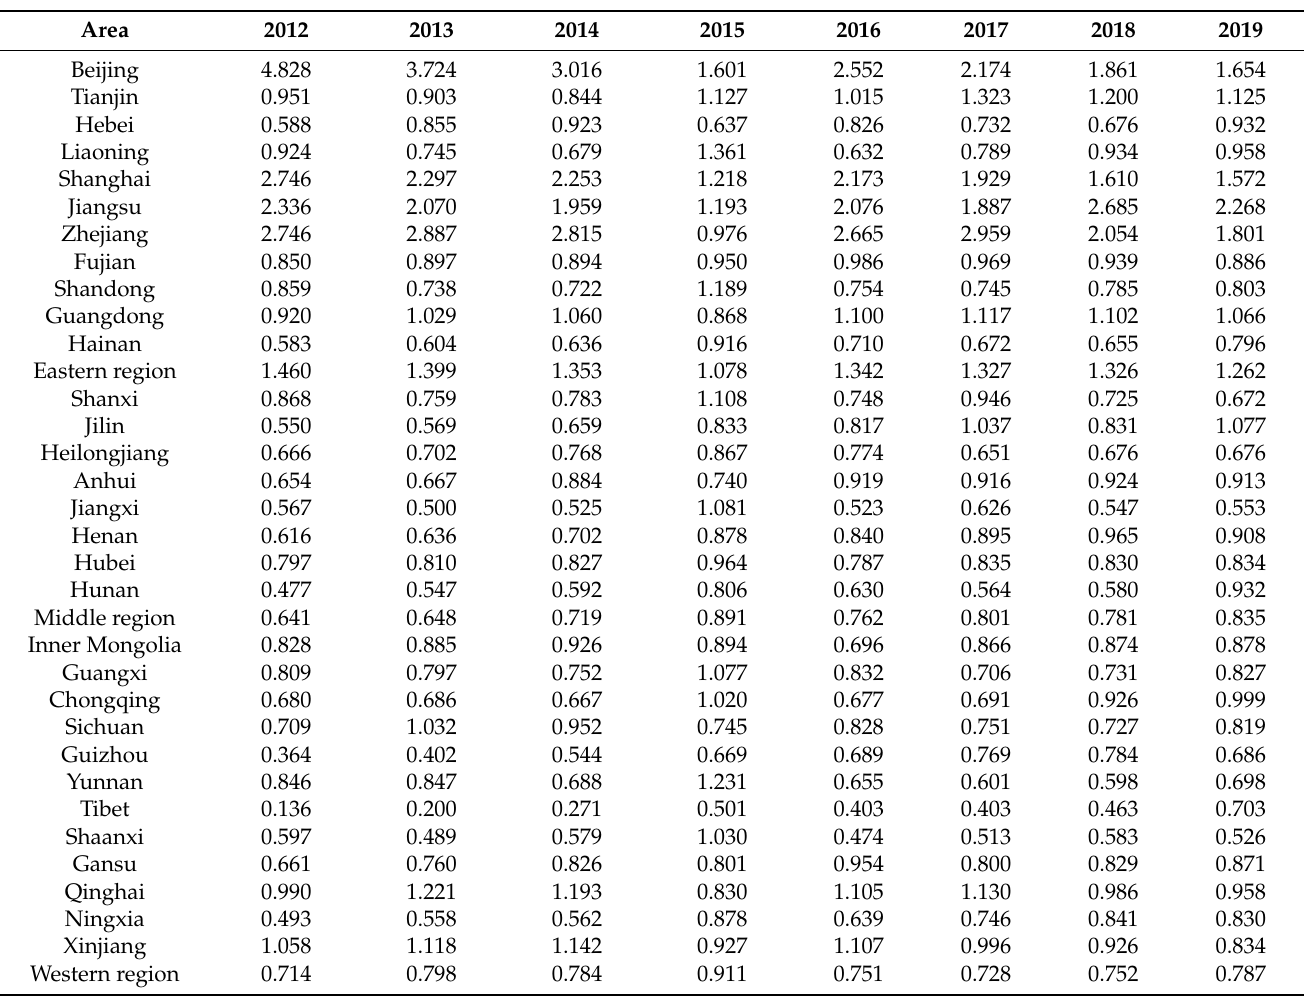
Table 11. The HRAD i /PAD i of GP allocation in 2012–2019 in